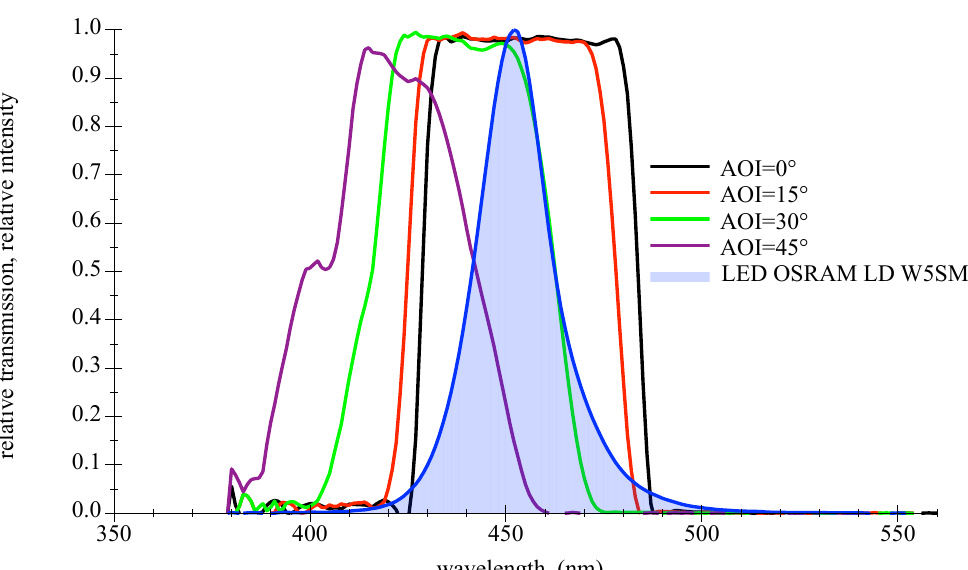
Figure 12. Measured spectral transmission curves for a thin film bandpass filter Semrock 457-50 with a directed light source at different AOIs. The measured relative intensity distribution of a deep blue LED OSRAM LD W5SM is also given as filled curve to illustrate the overlap. For further information please refer to the appendix in Appendix A.3.